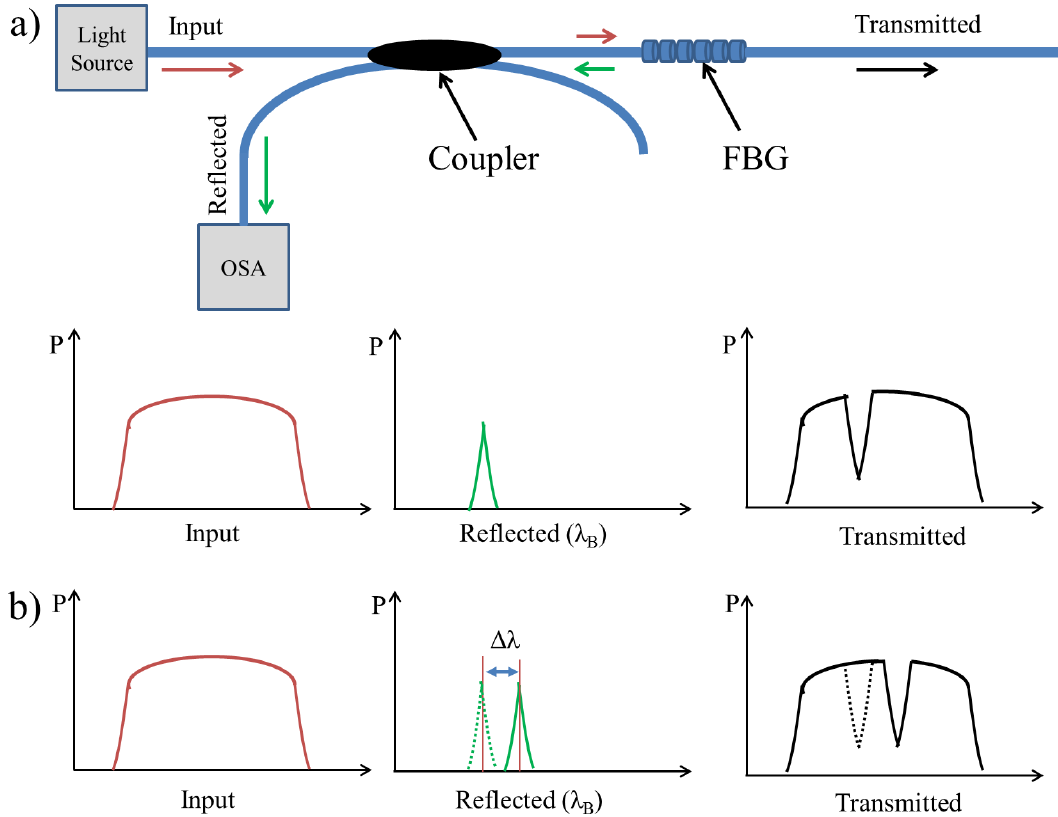
Figure 1. ( a ) The light source (Brown color) is transmitted through the FBG and a narrow band (Green color) is back-reflected, centred around λ back-reflected band is shifted (Δ λ ) shortly after applying external